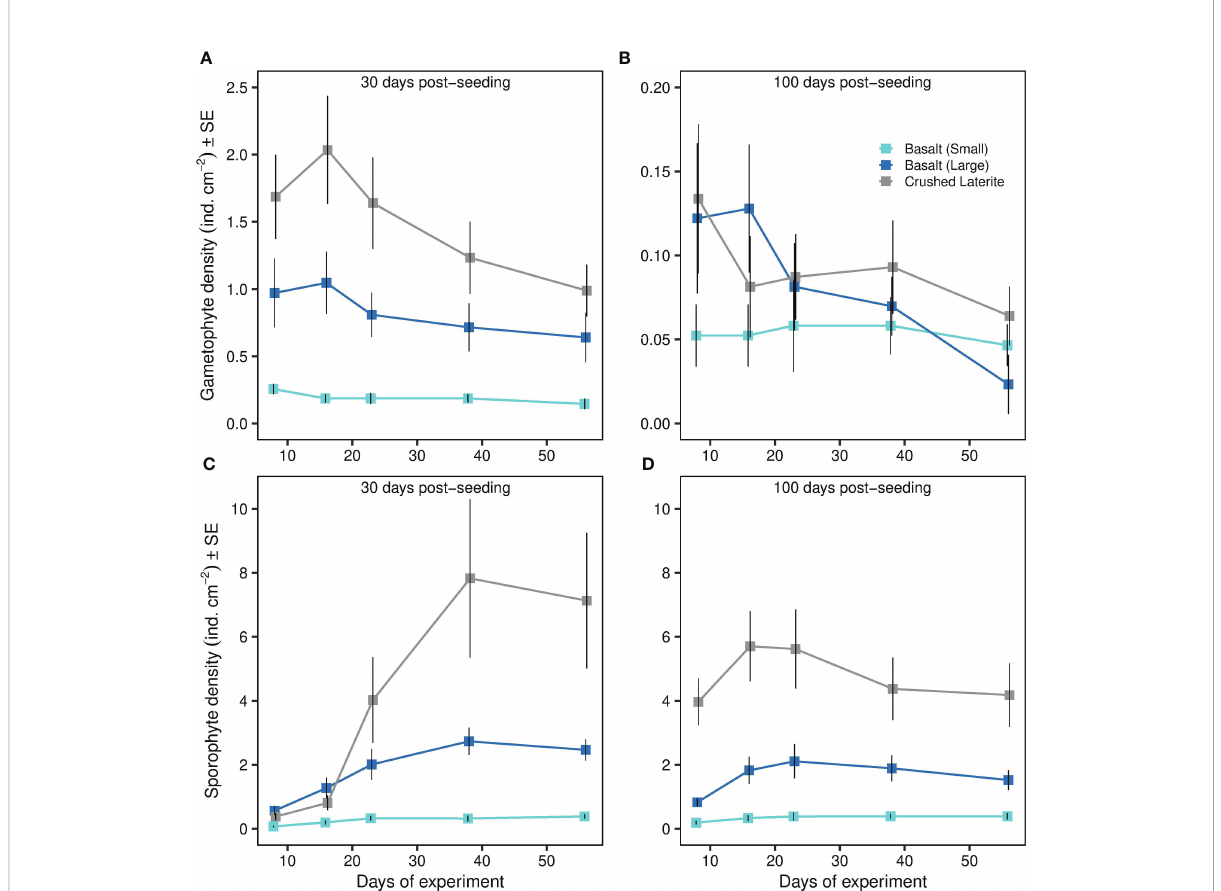
FIGURE 5 Effects of substrata and post-seeding time on Ecklonia radiata (A, B) gametophyte detachment and (C, D) reproductive success of detached gametophytes over time. Gametophyte detachment from gravel (i.e. gametophyte density) is expressed as the number of gametophytes cm -2 adhered to the dish surface around the gravel. Reproductive success (i.e. sporophyte density) is expressed as the number of sporophytes cm -2 adhered to the dish surface around the gravel. Data represent mean ± SE. Colours refer to the type of substrata. Please note different scale on